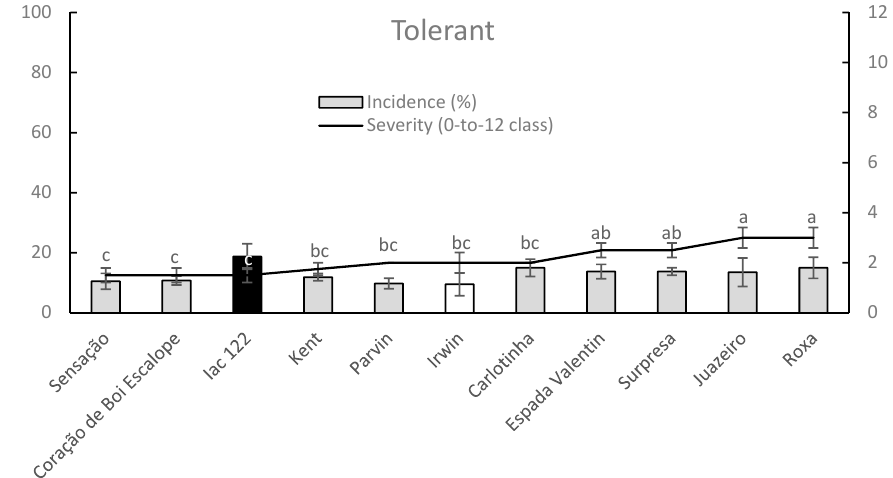
intermediate leaf anthracnose severities (data not significant) (Figure 6).